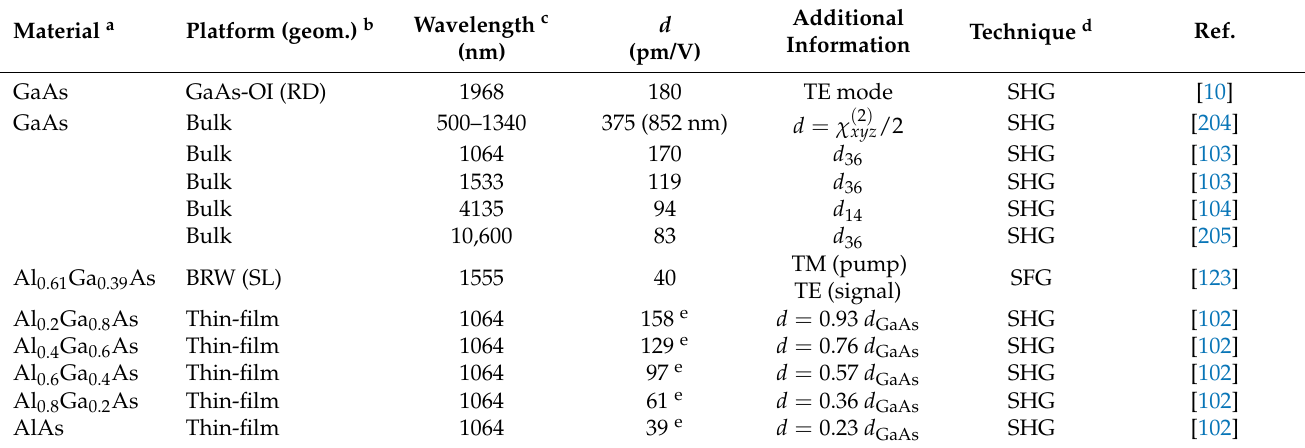
Table 3. Second-order nonlinear